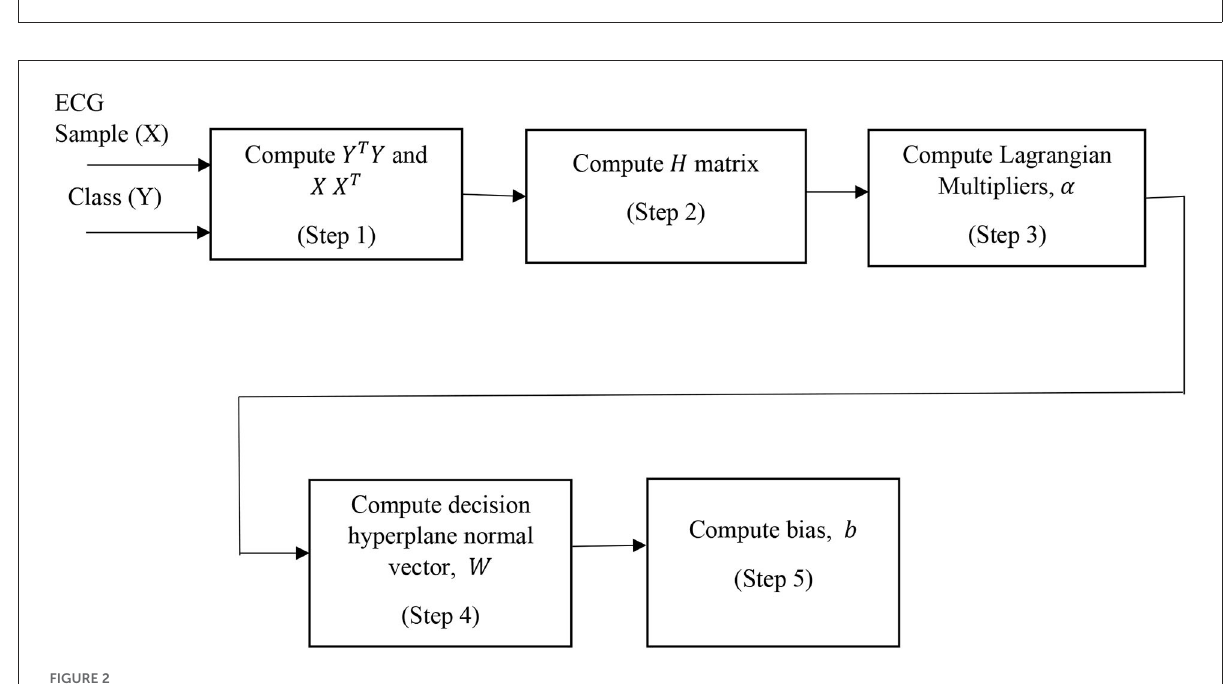
FIGURE2 Block diagram of SVM classification